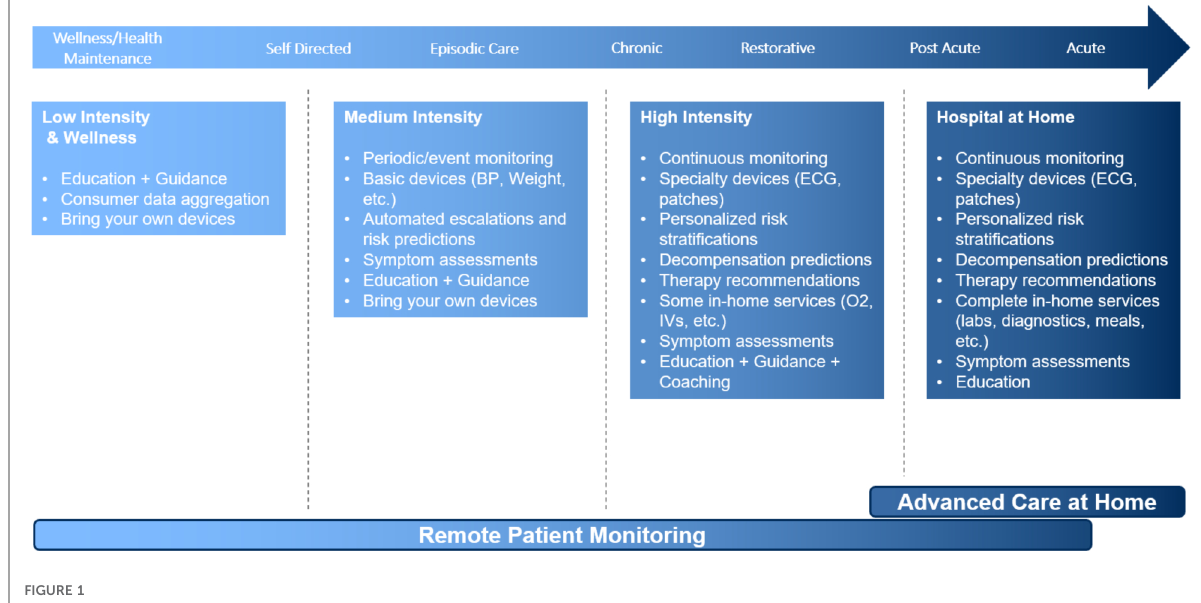
FIGURE 1 Matching RPM program components with patient